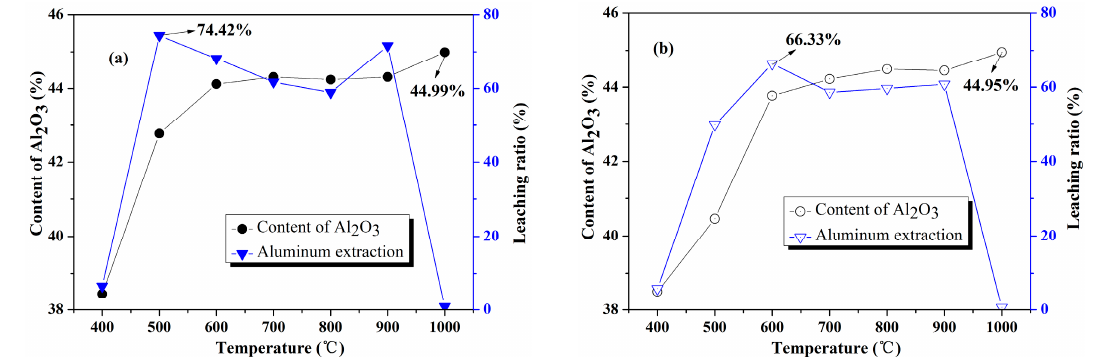
Figure 6. Aluminium leaching rate of calcined products by fluidized calcination ( a ) and static calcination ( b ) at various temperatures.